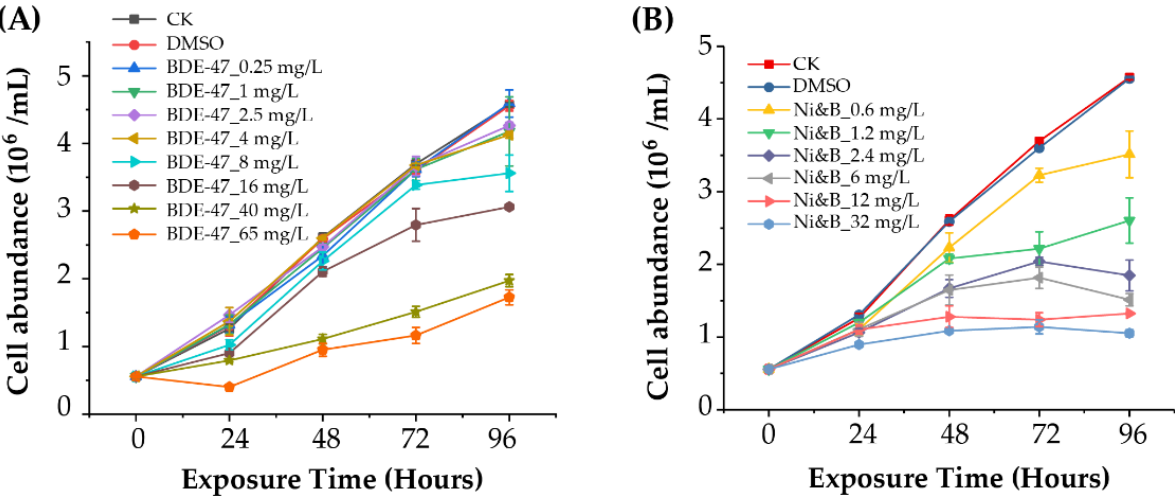
Figure 1. Cell abundance of Phaeodactylum tricornutum after individual BDE-47 treatment ( A ) and treatment with mixtures of BDE-47/nickel ( B ). Error bars indicate ± standard deviations (SD) of means. p -values are shown in Table S3.